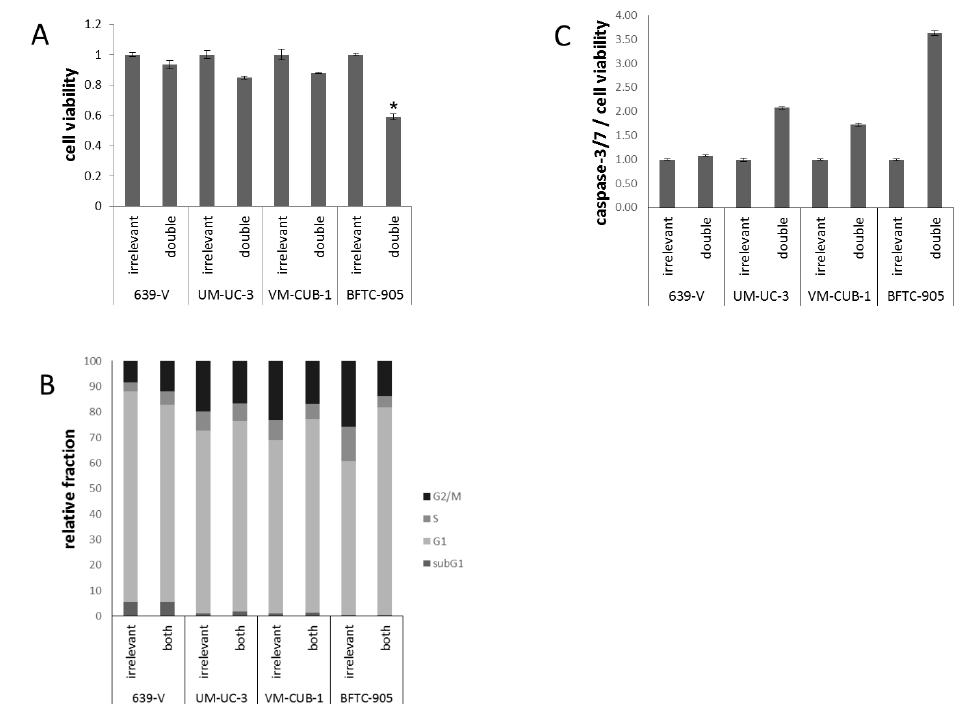
Figure 7. Cellular effects of double GNAT knockdown. ( A ) Cell viability 72 h after combined GCN5/PCAF knockdown in UCCs as measured by CellTiter-Glo assay (measuring total ATP). For each cell line, values were set as 1 for the treatment with irrelevant siRNA; ( B ) Cell cycle distribution after combined GCN5/PCAF knockdown in UCCs as measured by flow cytometry (mean of triplicate values). The amount of apoptotic cells is reflected as subG1 fraction; ( C ) Caspase 3/7 activity after GCN5 or PCAF knockdown in UCCs. Values obtained by the Caspase-Glo assay were normalized to viability of each condition. For each cell line, values were set as 1 for the treatment with irrelevant siRNA. Asterisks denote significant differences, * p < 0.05.